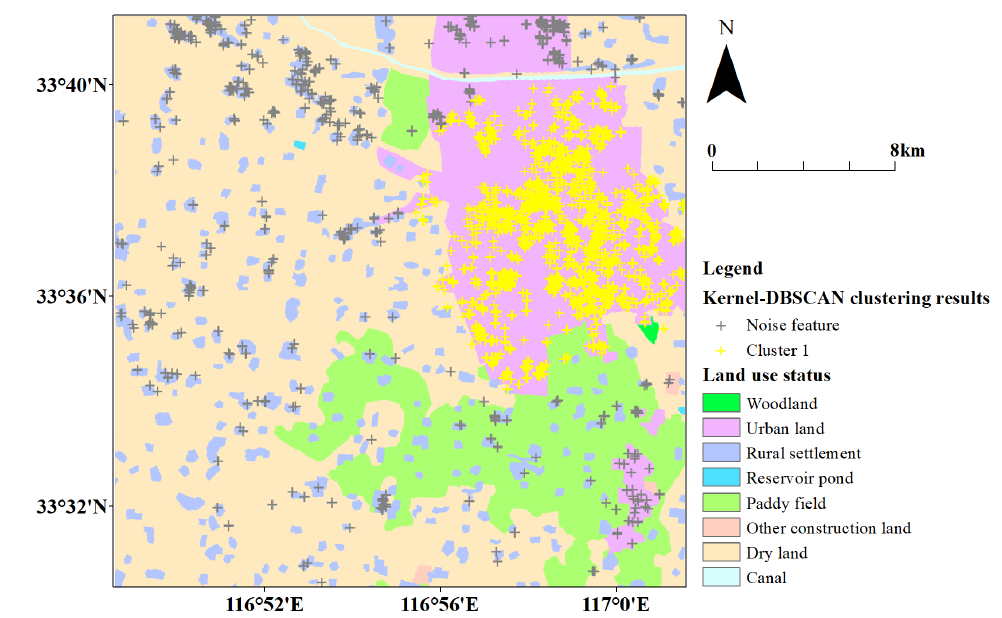
Figure 14. The results of Kernel-DBSCAN clustering.